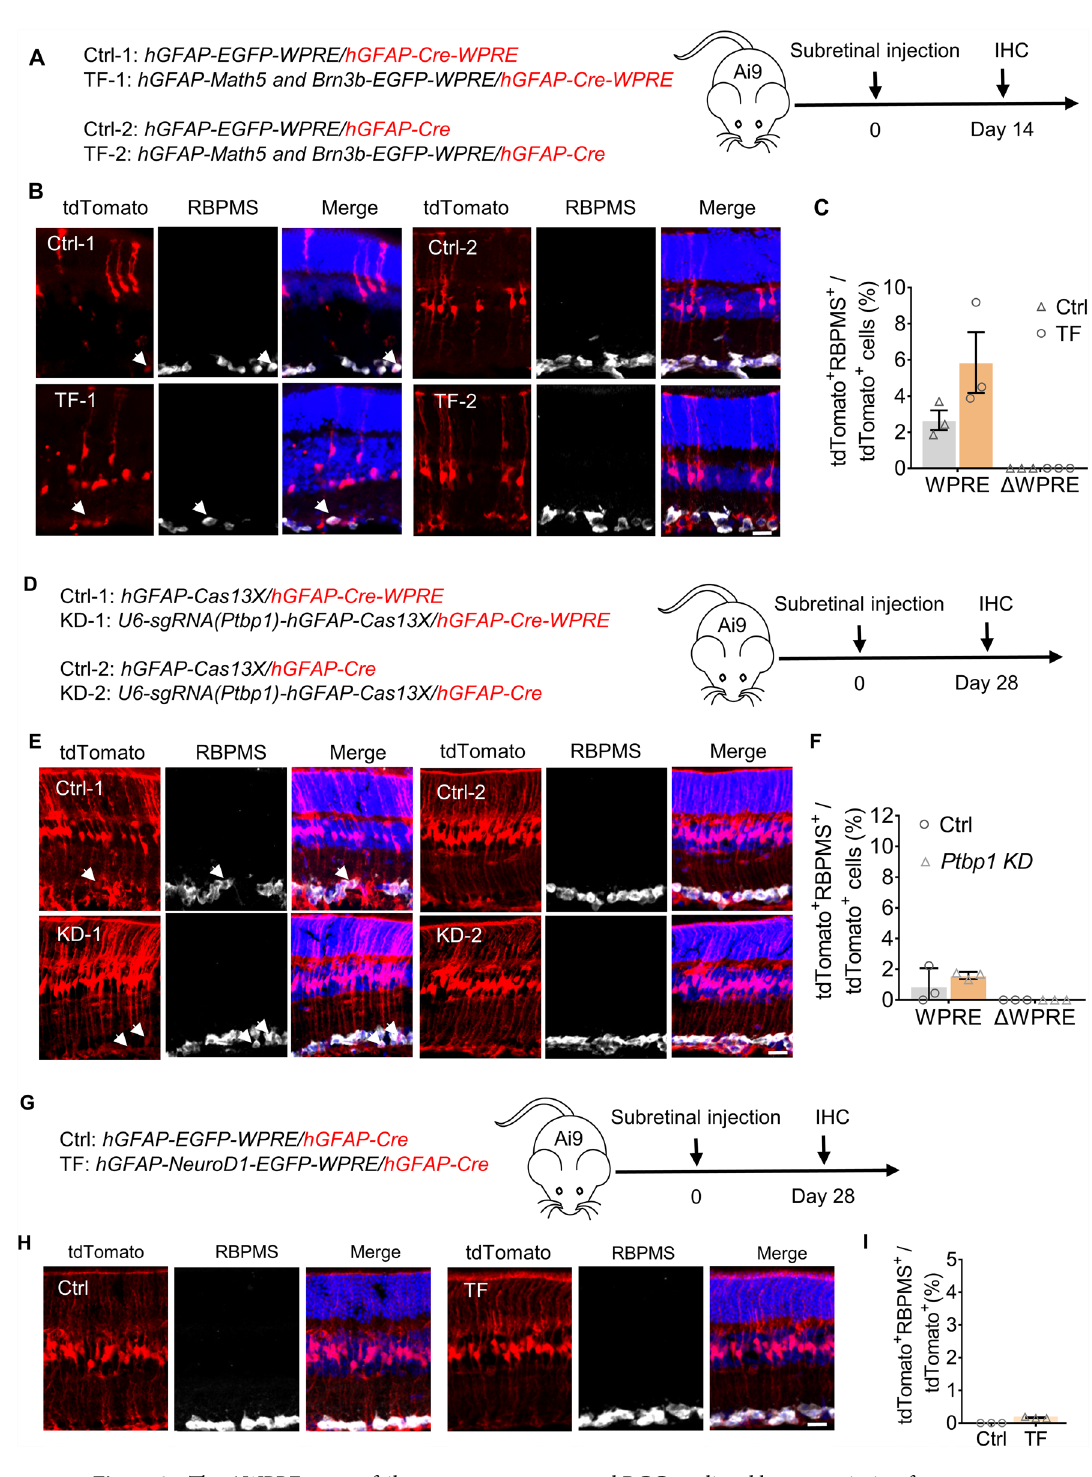
Figure 3. The ΔWPRE system fails to trace reprogrammed RGC mediated by transcription factors overexpression or knockdown. ( A ) Schematic diagram of vectors for Math5 and Brn3b overexpression and injection process. ( B ) Representative images of tdTomato co-labeling with Rbpms at 2 weeks after injection. ( C ) The ratio of tdTomato-labeled RGCs among total tdTomato + cells. ( D ) Schematic diagram of Ptbp1 knockdown and injection process. ( E ) Representative images of tdTomato co-labeling with Rbpms. ( F ) The ratio of tdTomato-labeled RGCs among total tdTomato + cells. ( G ) Schematic diagram of NeuroD1 overexpression. ( H ) Representative images of tdTomato co-labeling with Rbpms. ( I ) The ratio of tdTomato-labeled RGCs among total tdTomato + cells. n = 3 for each group. Arrows show tdTomato + Rbpms + cells in panels B, E, H. Scale Bar, 50